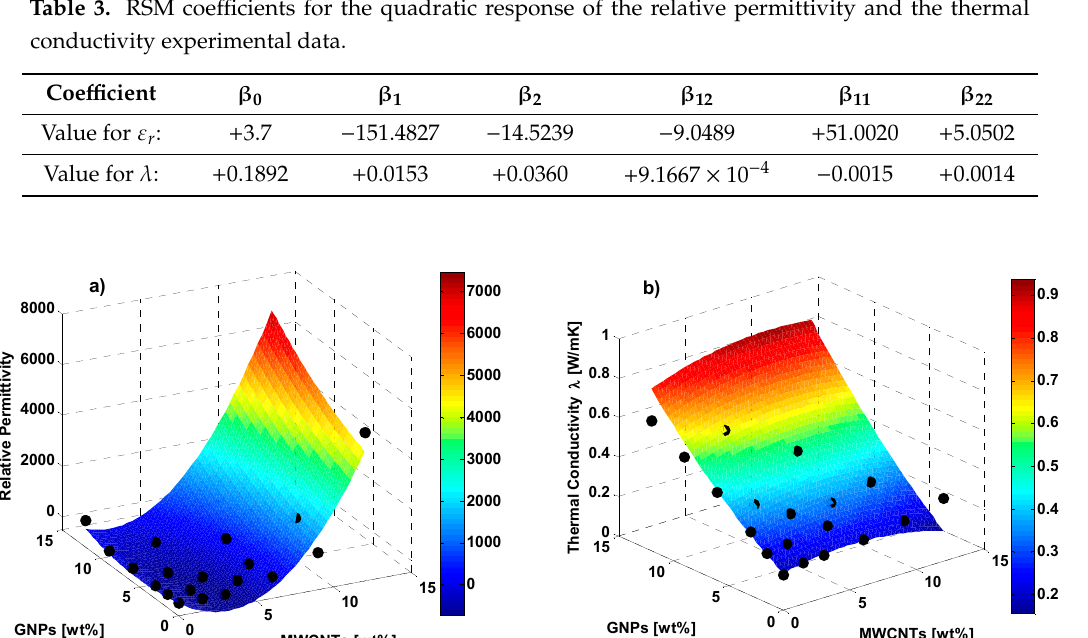
Figure 22. Quadratic response RSM for the relative permittivity and the thermal conductivity as a function of the two fillers percentage (color map), together with the experimental data (black markers), in ( a ) and ( b ), respectively.